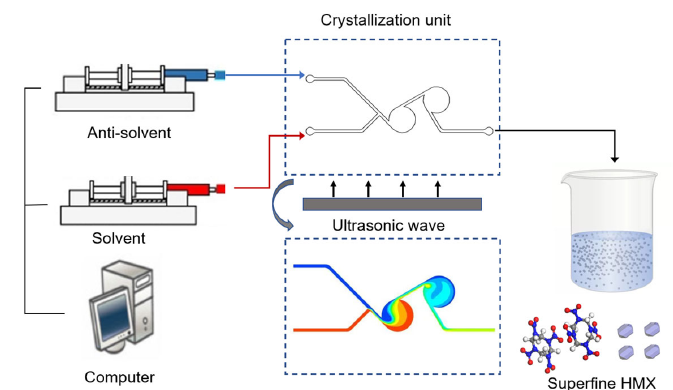
Figure 1. Schematic diagram of the microfluidic platform.